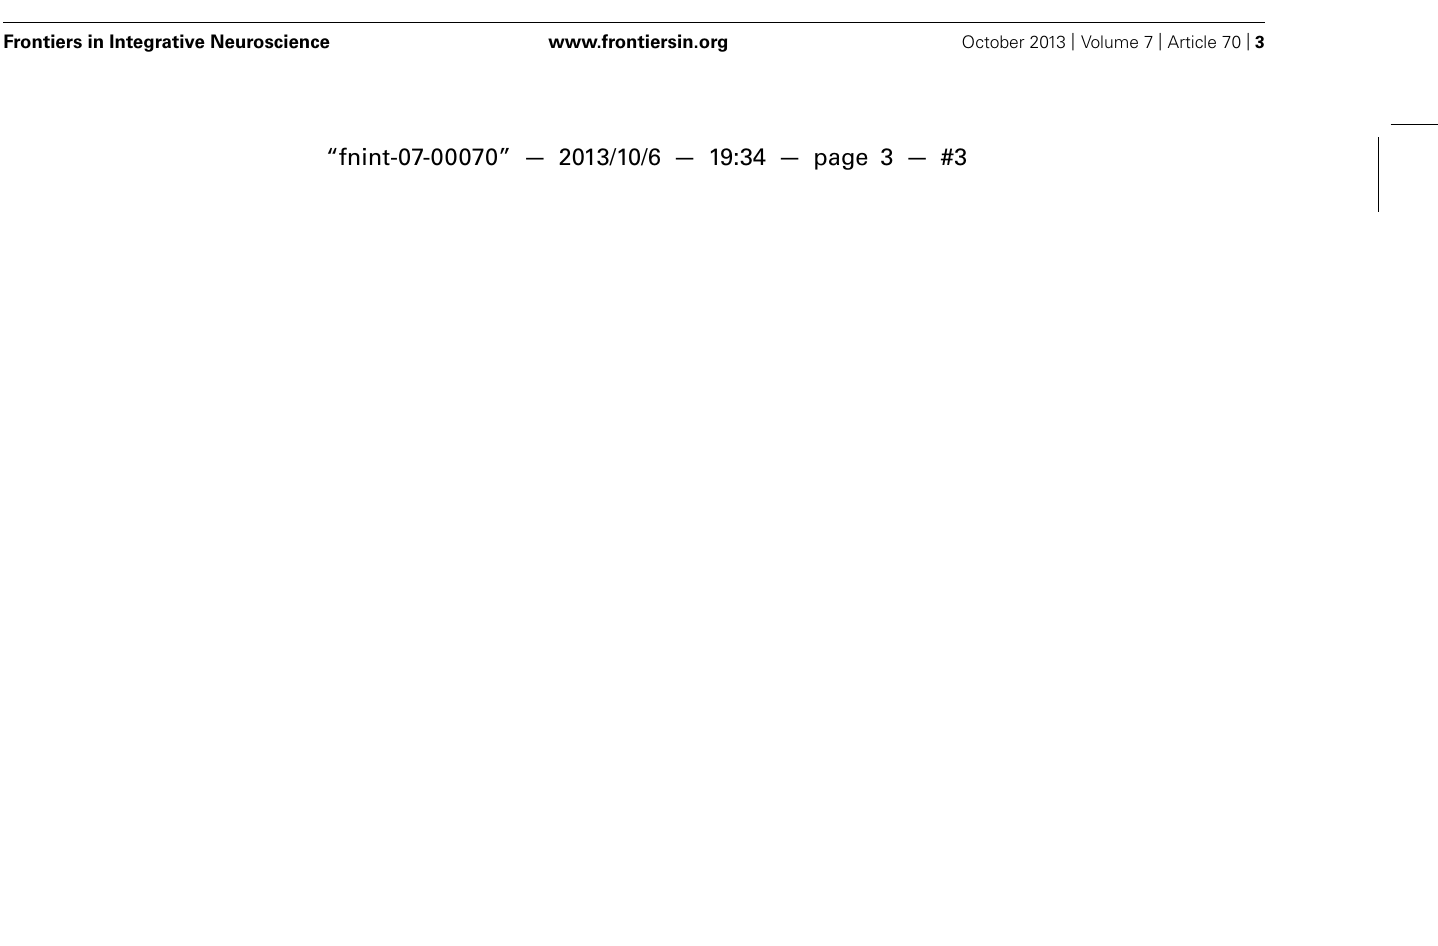
FIGURE 1 | (A) Microbiota–gut–brain (MGB) axis. Direct and indirect pathways support the bidirectional interactions between the gut microbiota and the central nervous system (CNS); involving endocrine, immune and neural pathways. On the afferent arm (blue arrows): (1) lymphocytes may sense the gut lumen and internally release cytokines which can have endocrine or paracrine actions, (2) Sensory neuronal terminals, such as on the vagus nerve may be activated by gut peptides released by enteroendocrine cells, (3) Neurotransmitters or its precursors produced as microbiota metabolites may reach the gut epithelium having endocrine or paracrine effects. (4) Centrally, after brainstem relays (e.g., nucleus tractus solitarii ) a discrete neural network has been described consistently involving the amygdala (Am) and the insular cortex (IC) as main integrators of visceral inputs. Consistently hypothalamic (Hy) activation initiates the efferent arm (red arrows): (5) corticosteroids,